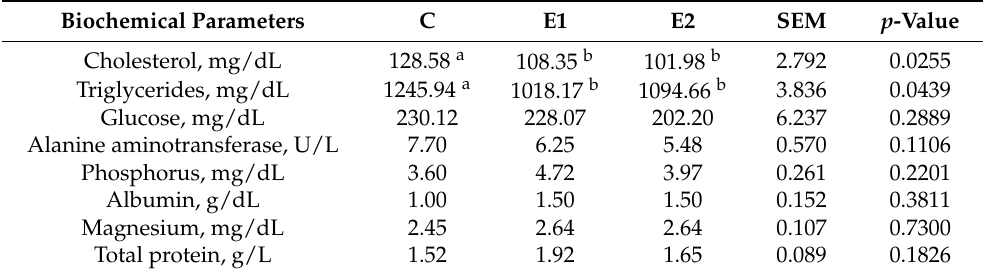
Table 5. Biochemical parameters of laying hens fed diets supplemented with watermelon rind and sea buckthorn meal. Biochemical Parameters